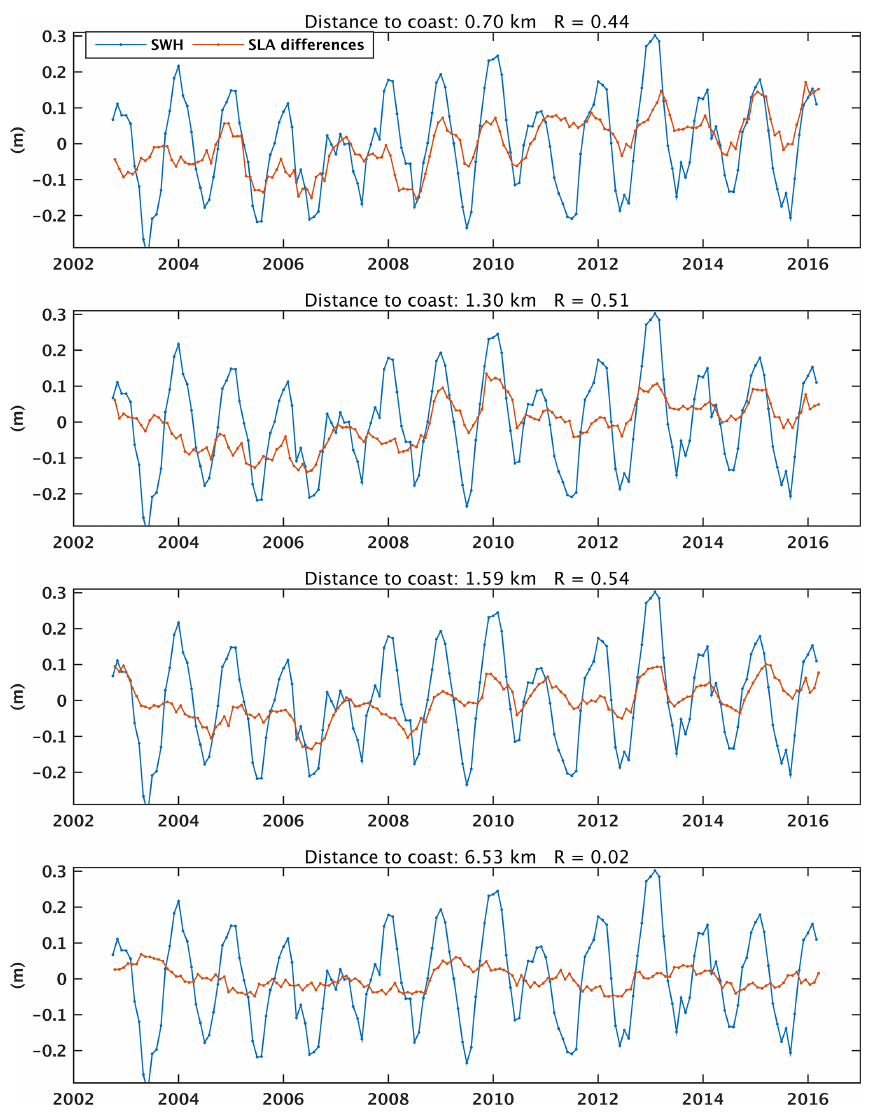
Figure 16. Time series of ERA5-based wave height time series (blue curve) and of altimetry-based SLA differences (orange curve) between 20Hz points at different distances from the coast (indicated on each plot) and a reference point (located at